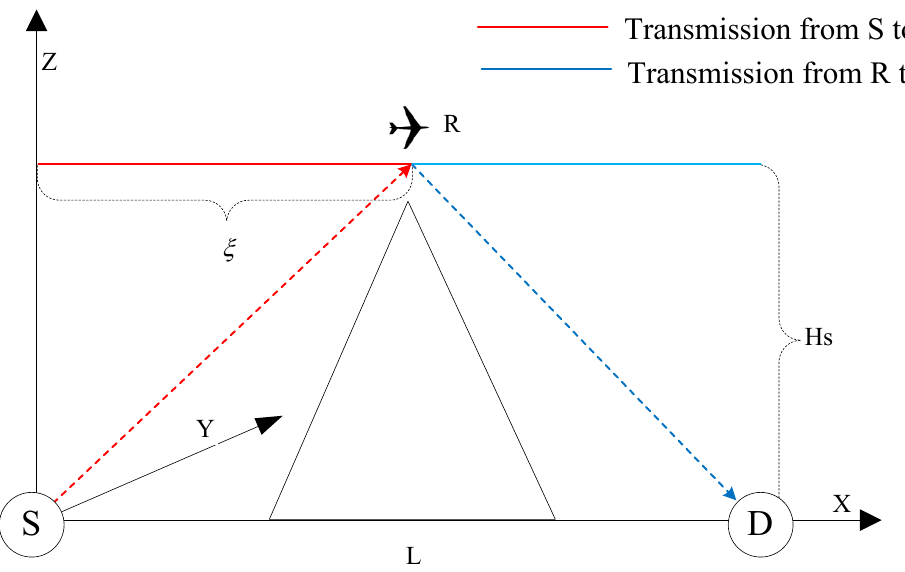
Figure 2. UAV-enabled communication system under SLF flight